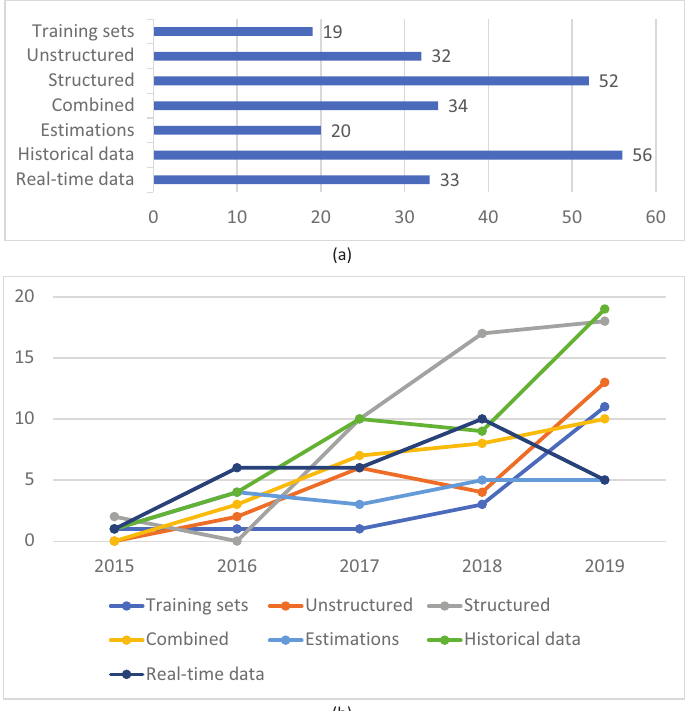
Figure 8. ( a ) Data type categories addressed by 20 or more primary studies; and ( b ) number of primary studies addressing data type categories in the period.